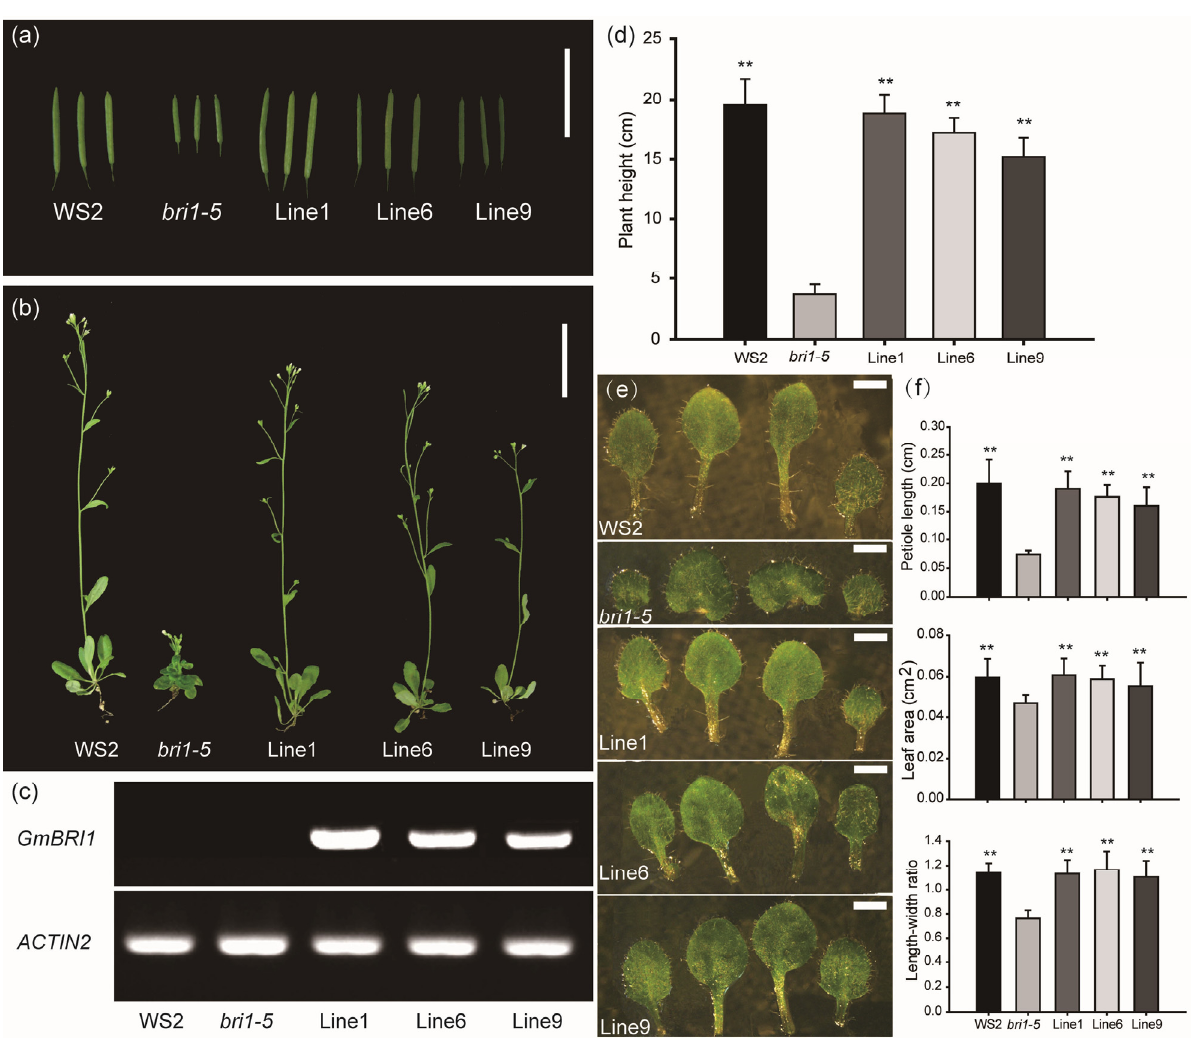
Figure 3. GmBRI1 complementation of bri1-5 in the phenotype. ( a ) Silique morphology comparison among the wide-type (Waardenburg syndrome type 2, WS2), bri1-5 mutant and three transgenic lines (Line 1, 6 and 9). Bar = 10 mm; ( b ) Phenotype comparison of adult plants. Bar = 40 mm; ( c ) Real-time polymerase chain reaction (RT-PCR) analysis to detect the GmBRI1 gene using the specific primers described in Table S1, AtACTIN2 (GenBank accession No. AT3G18780) as a reference gene; ( d ) Plant height statistics with a sample capacity of 20 plants per group; ( e ) Leaf phenotypes from 13-day-old plants. Seedlings were photographed under a Nikon SMZ1500 dissection microscope using a Nikon DS-Fi1 camera (Nikon, Mississauga, ON, Canada) and NIS-Elements F Imaging software (Nikon, Mississauga, ON, Canada). Bar = 1 mm; and ( f ) Statistical analysis of leaf measurements: the petiole length, leaf area and length-width ratio of the first true leaves. The data represents the mean ± SD of three independent experiments. The asterisks indicate significant differences compared to the bri1-5 mutant ( ** , p < 0.01 by the t